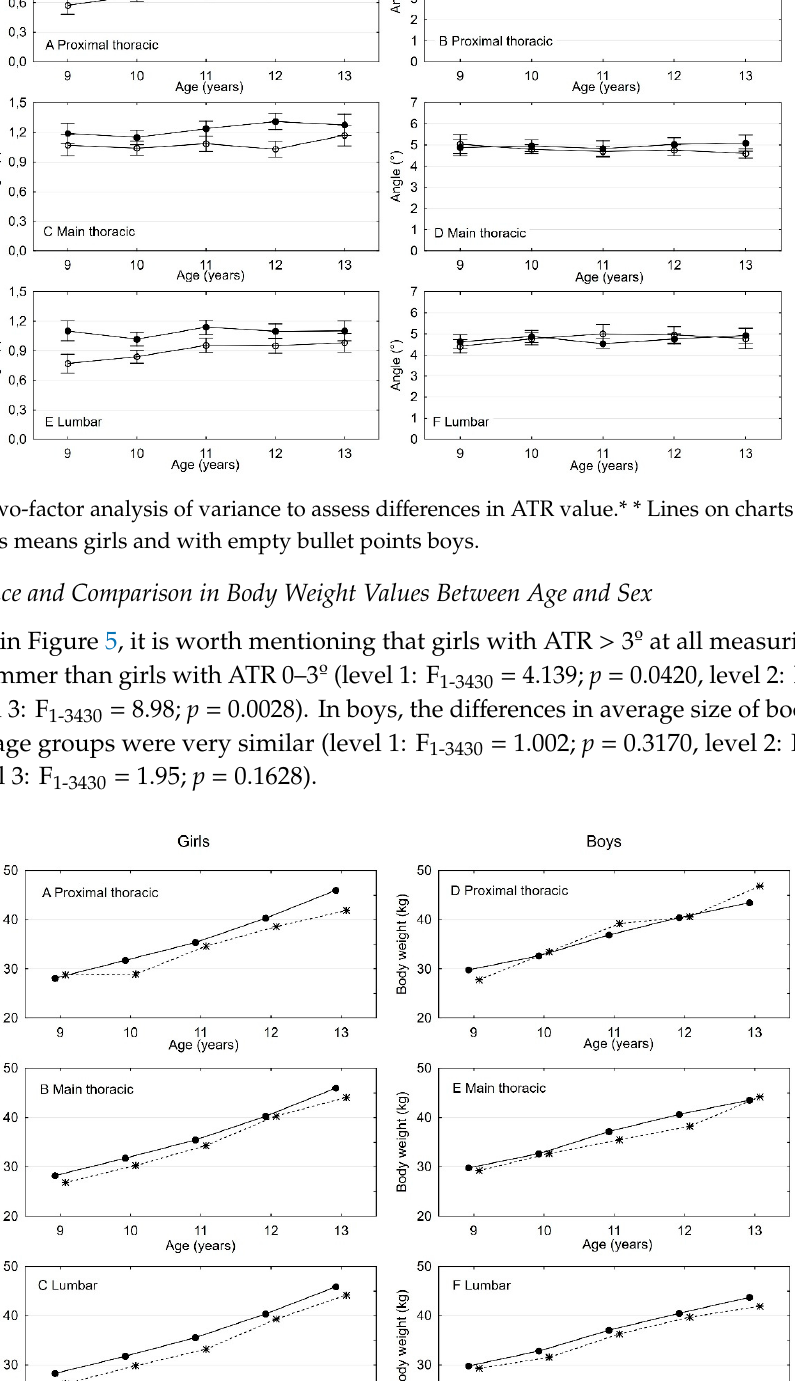
Figure 5. Two-factor analysis of variance to assess differences in ATR value with body weight. * *